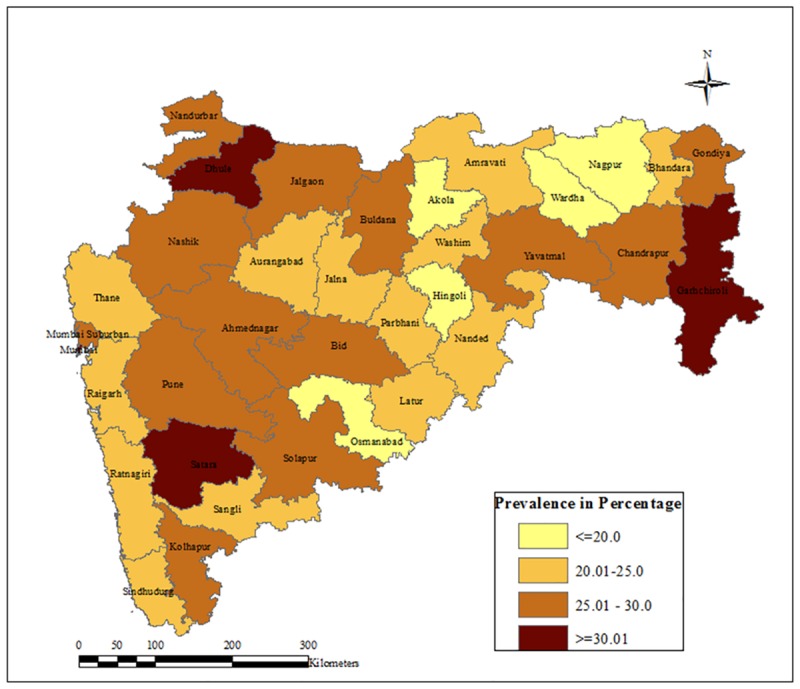
Prevalence of hypertension in Maharashtra, 2012–13.